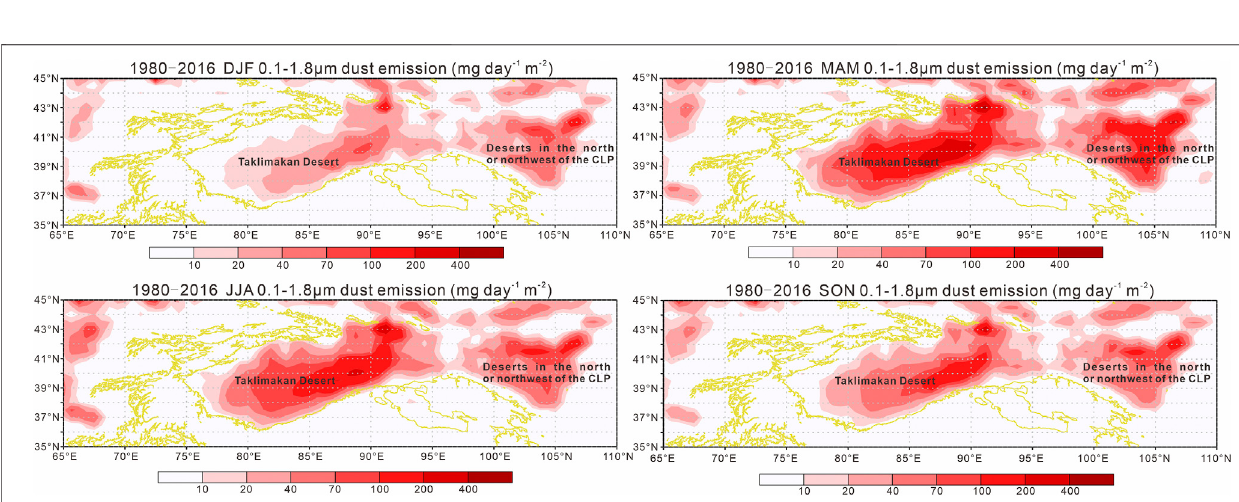
Frontiers in Earth Science |